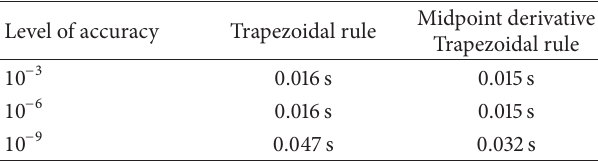
Table 5: CPU time for ∫